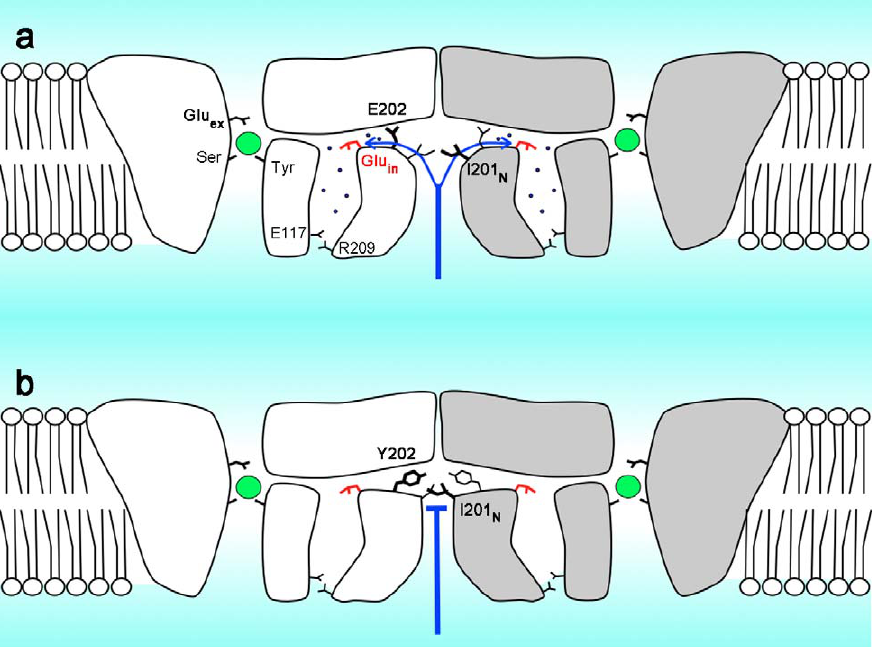
Figure 6. Proposed mechanism of intracellular H + access. Cartoon depicts (a) homodimeric CLC-ec1, with subunits colored grey or white. In each subunit, Cl 2 (green spheres) and crystallographic water molecules (blue dots) are shown. The proposed water-mediated interfacial H + pathway connecting bulk intracellular water to the protein interior is indicated by blue arrows. Also shown are Glu in (red sticks) and the serine, tyrosine, and extracellular glutamate residues that coordinate the central Cl 2 . (b) E202Y mutant, with its substituted side chain pointing out to the blocked interfacial pathway and recruiting I201 N (N denotes residue of neighboring subunit). Stick thickness represents vertical location of side chains. The polar pathway is also indicated as capped by the E117-R209 salt